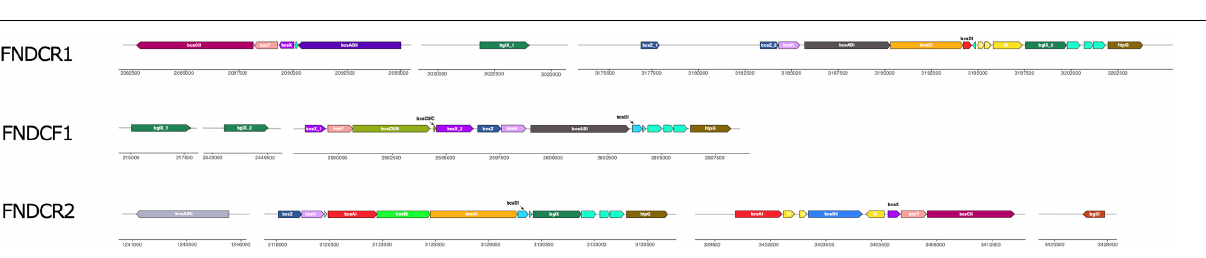
genus. Phylogenetic tree analysis of the conserved core genes indicated that the three strains belong to mutually different clades. None of them matches any known